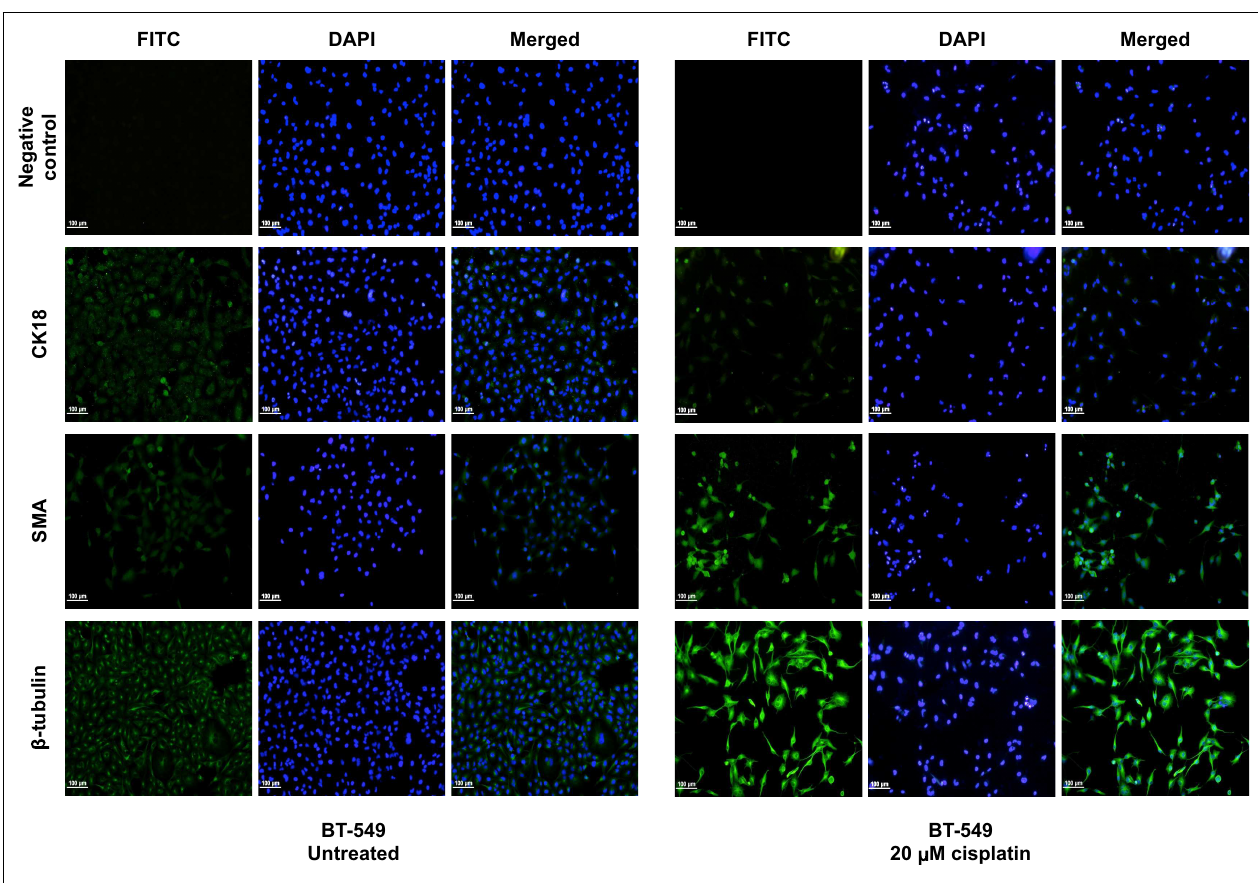
FIGURE 3 | Cisplatin influences expression of differentiation markers in BT-549 cells . Differentiation markers SMA and β -tubulin were up-regulated upon treatment with 20 µ M cisplatin in BT-549 cells. DAPI nuclear stain was used to stain the nucleus (blue), whilst all other markers are shown in green. Scale bars: 100 µ